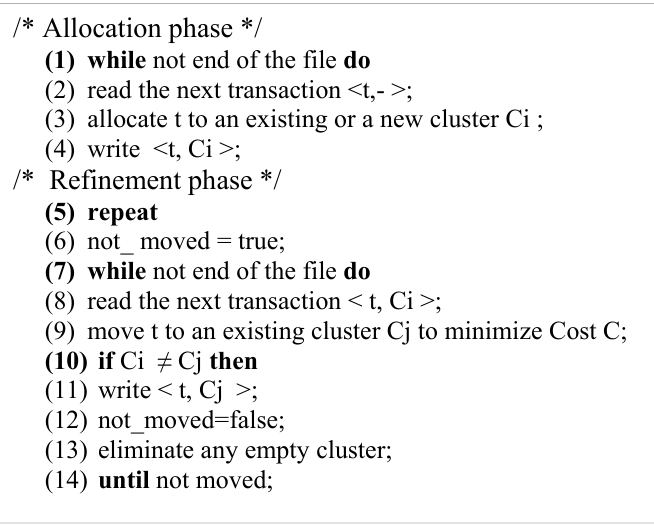
Fig. 1. Outline of Clustering